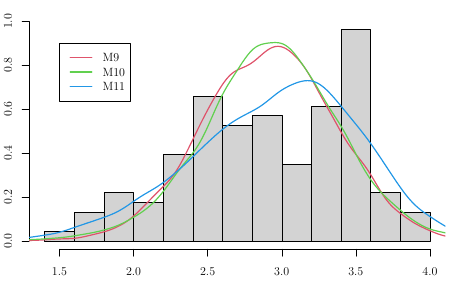
Figure 10 – Histogram of the Canadian lynx time series and the non-parametric kernel density estimation of 10000-length simulated trajectories from the TARMA models M9 –